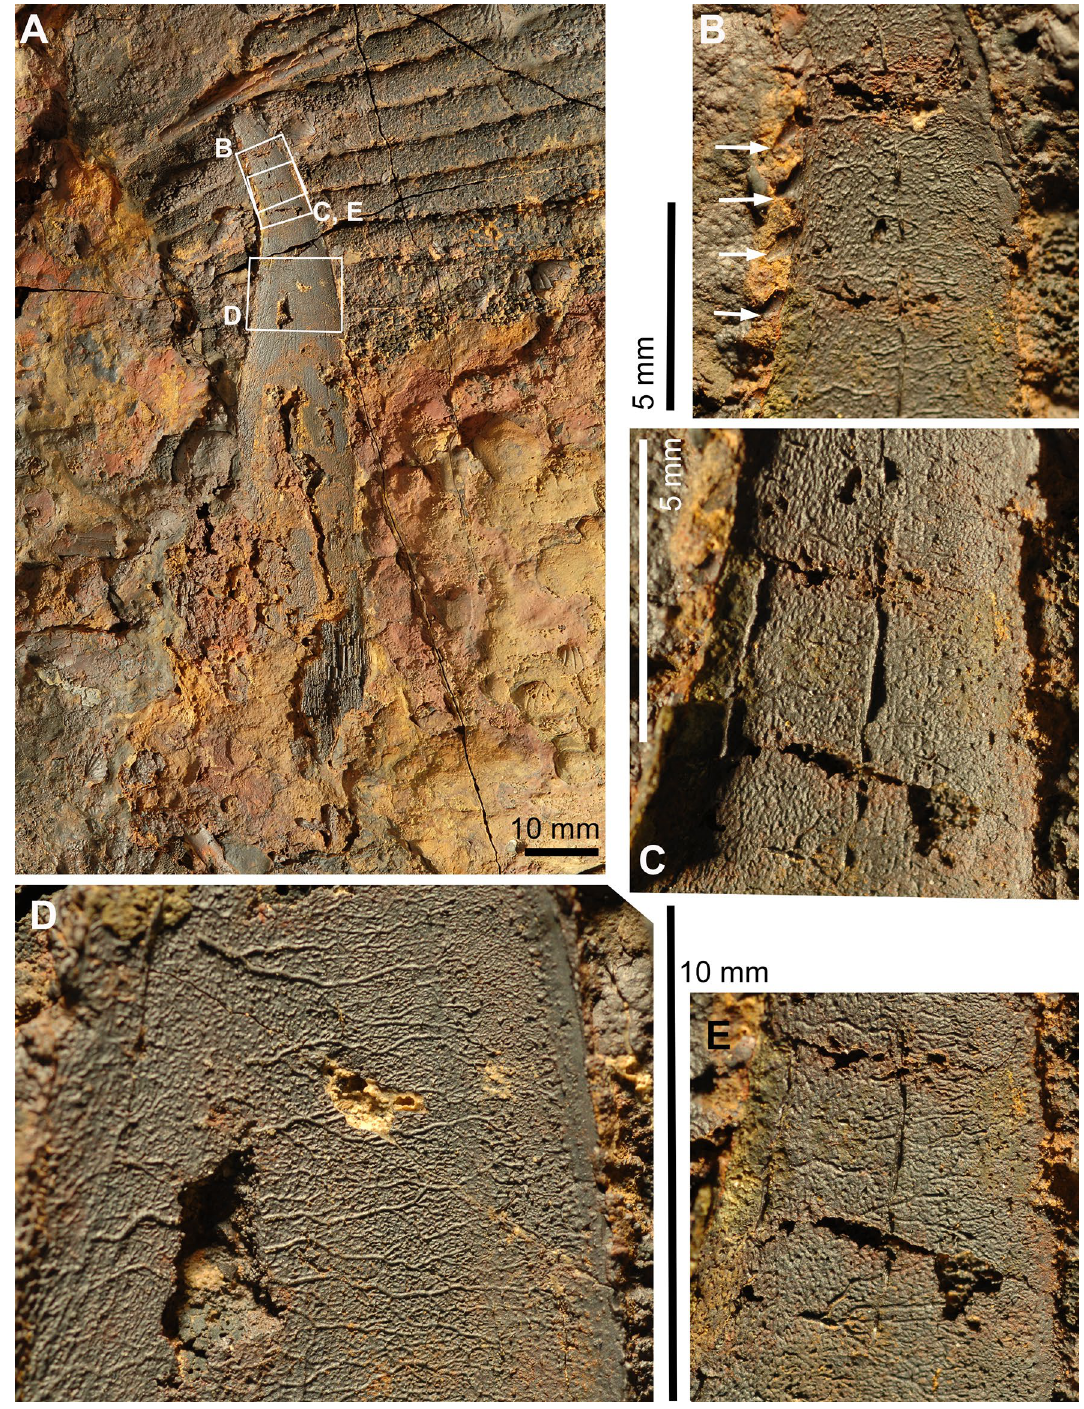
Fig. 10 Details of the fin spine of the anterior dorsal fin of Maghriboselache mohamezanei n. gen. et sp., PIMUZ A/I 5154. A overview, showing the localization of figures B to E. B detail of the tip with denticles at the posterior edge. C detail showing the fine longitudinal striation. D, E details showing imprints of blood